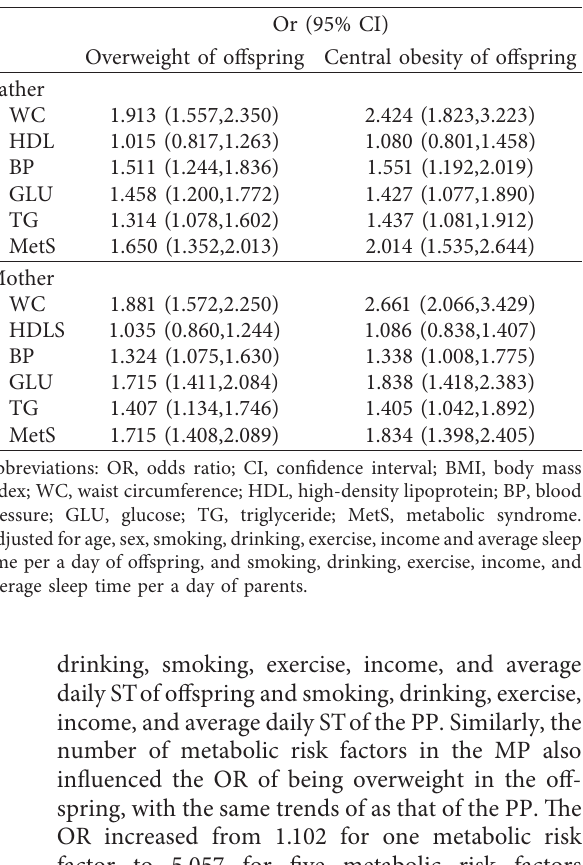
Table 3: Multivariate logistic regression analyses of overweight status and central obesity in offspring with parental metabolic risk